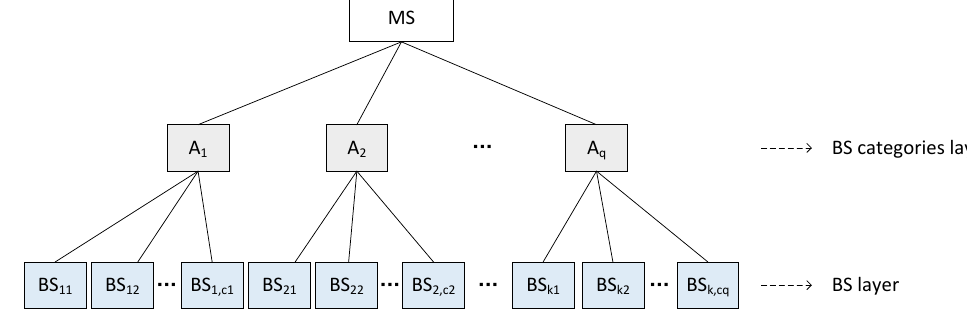
Figure 4. Business scenarios hierarchy model.